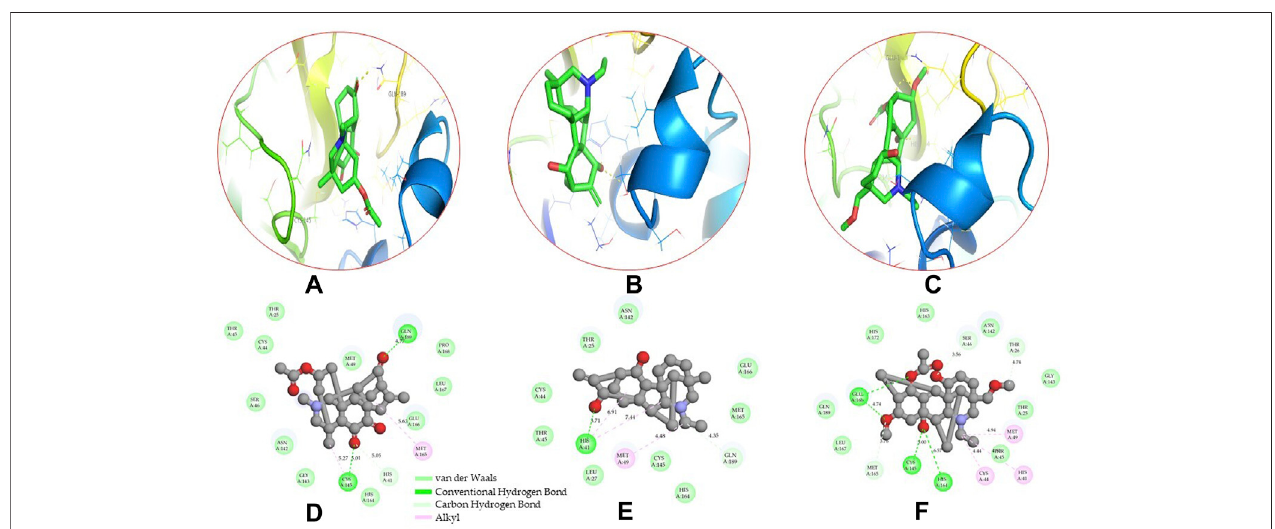
FIGURE3| 3Dand2Drepresentationsofthedockingcomplexesbetweenvilmorrianone,denudatine,condelphine,andM pro ofCOVID-19; (A) 3Dbindingmodeof vilmorrianonecompound withM pro active site; (B) 3Dbindingmode ofdenudatinecompound withM pro active site; (C) 3Dbindingmode ofcondelphinecompound with M pro active site. Molecules are represented as green sticks, M pro residues depicted as atom-type color sticks, while yellow dotted lines show the hydrogen bonds betweennaturalalkaloidsandM pro ofCOVID-19; (D) 2DrepresentationofM pro andvilmorrianonecomplex; (E) 2DrepresentationofM pro anddenudatinecomplex; and (F) 2D representation of M pro and condelphine complex. Molecular interactions such as van der Waals, conventional hydrogen bond, carbon – hydrogen bond, and alkyl are indicated by different colors. 3D and 2D representations of docking complexes are rendered with the help of PyMOL and Discovery Studio programs,